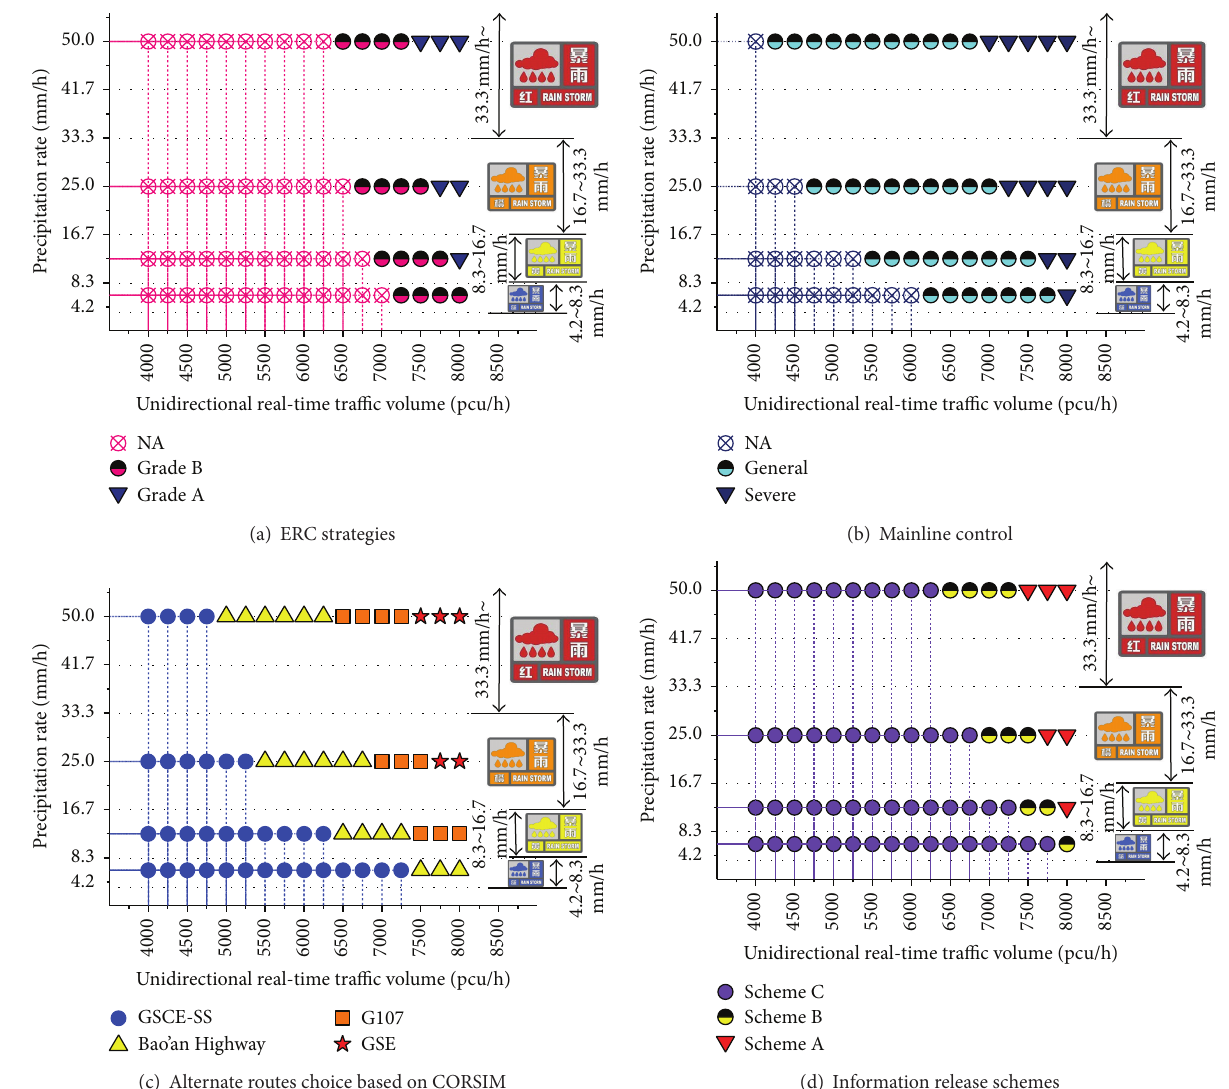
Figure 6: Maps of (a) ERC strategies; (b) mainline control; (c) alternate routes choice; (d) information release schemes, under scenarios of different volume and rainstorm warning grades (BLUE to